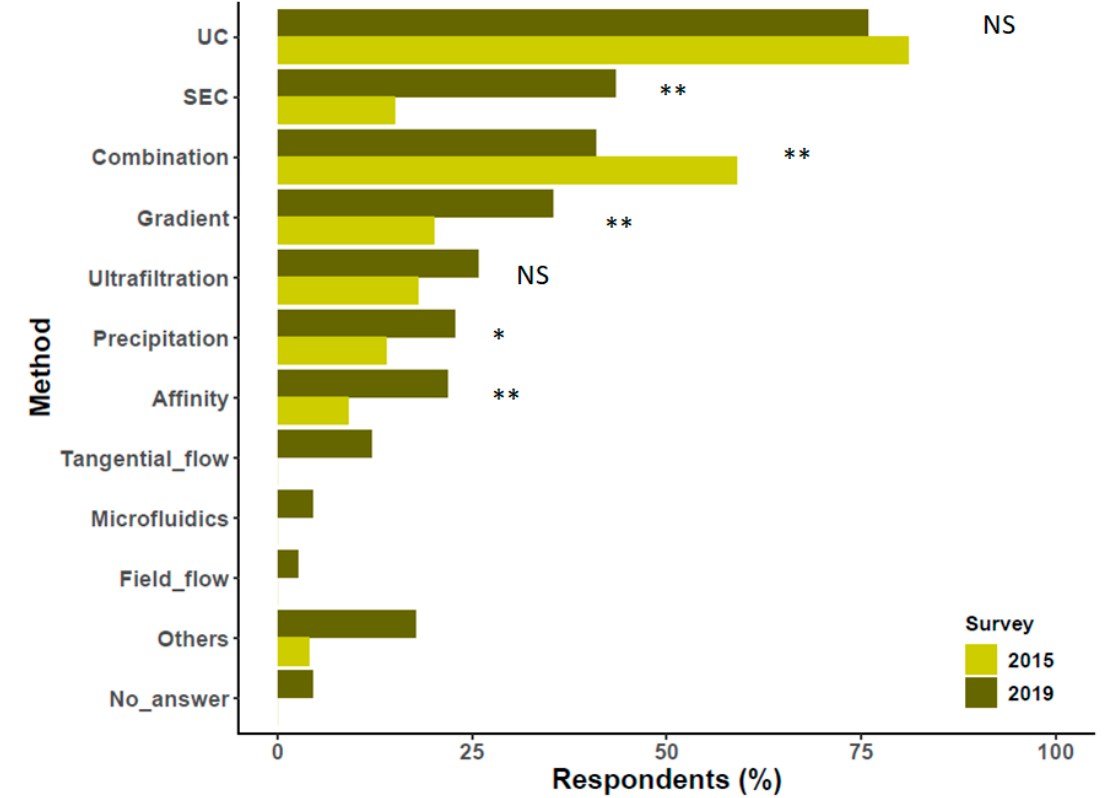
Figure 3. Methods used for EV separation compared with results of Gardiner et al. [8]. Results based on 357 responses. Differences between proportions were tested by a z test, and p values were obtained by a chi-square test (NS, non-significant, * p < 0.05, ** p < 0.01. Missing bars: not queried in the 2015